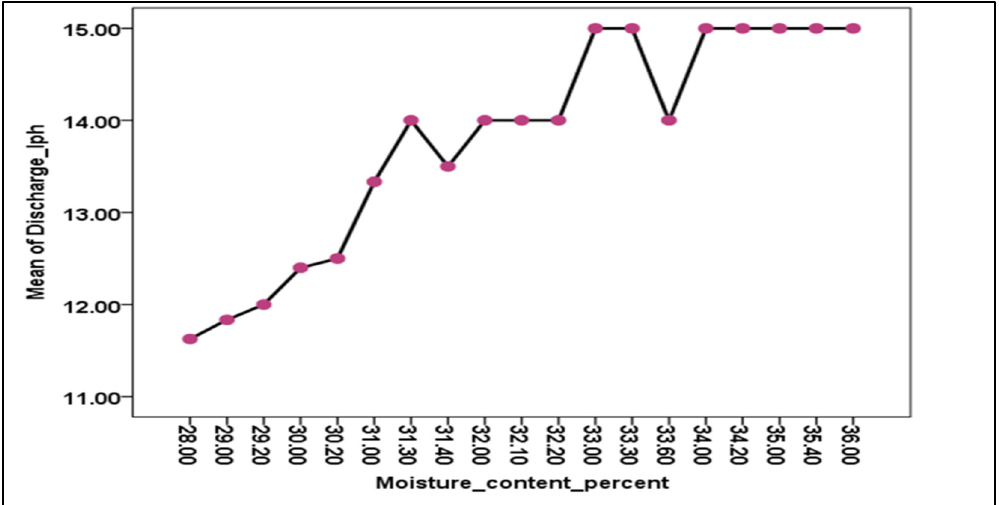
Figure 12. One-way ANOVA mean discharge (lph) by moisture content (%).